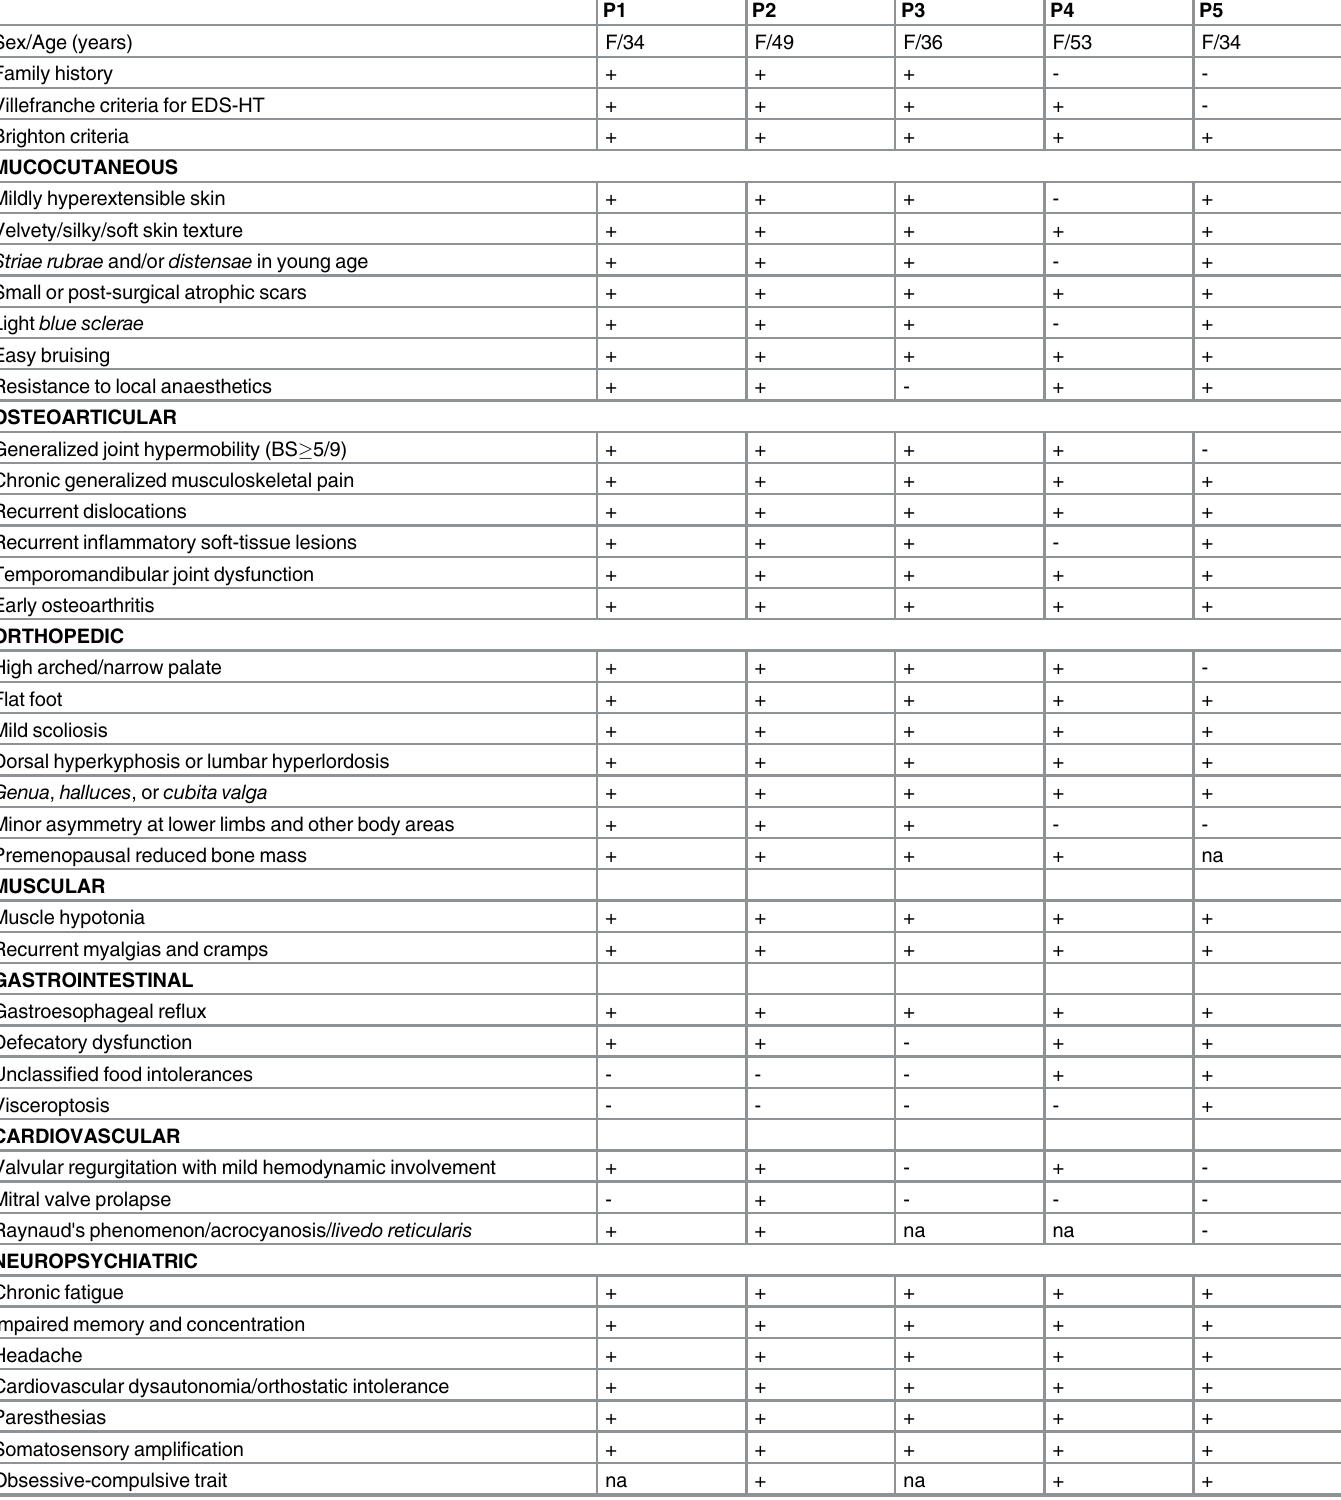
Table 1. Clinical findings of JHS/EDS-HT